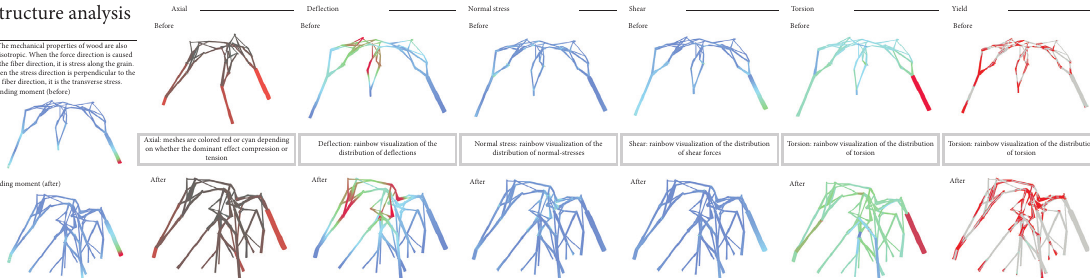
Figure 10: Structural performance analysis.